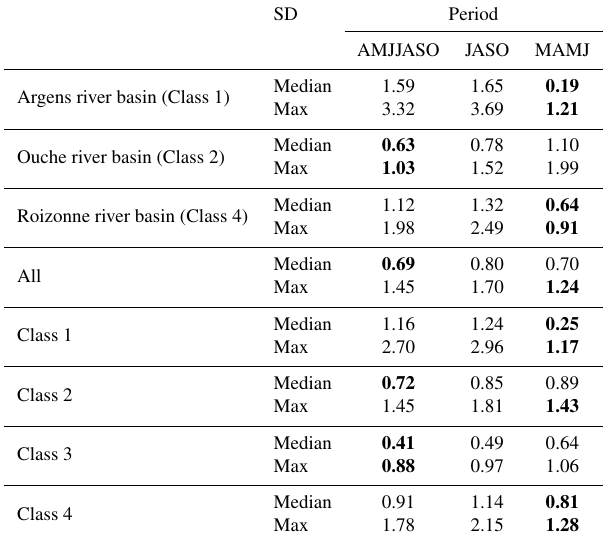
Table 5. Summary statistics for standard deviation (SD) of the grid for different axes. Best results are in bold characters.